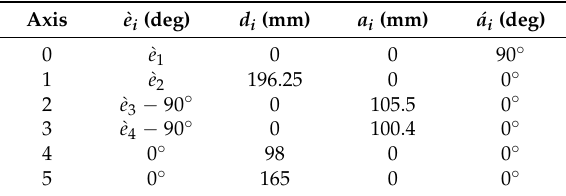
Table 1. The Denavit-Hartenberg (D-H) parameters of the robotic arm.